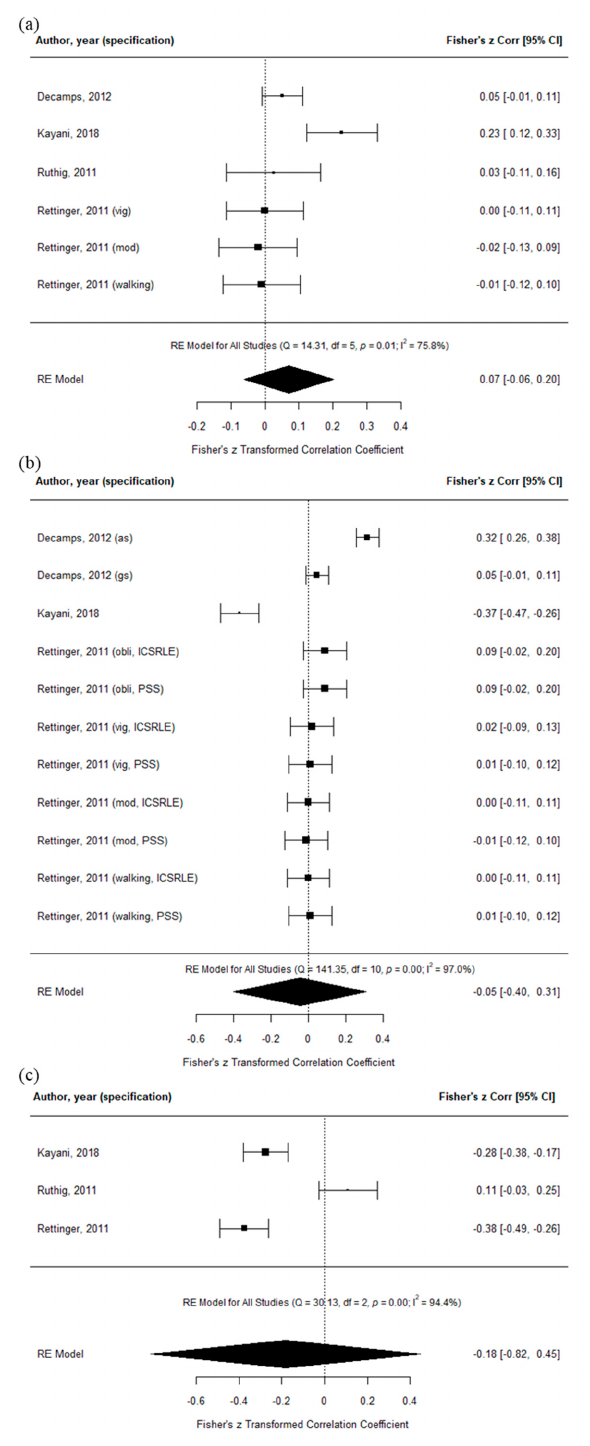
Figure 3. Forest plots of bidirectional relationships. ( a ) Physical activity and academic performance; ( b ) physical activity and stress; ( c ) stress and academic performance. Abbreviations: vig: vigorous physical activity; mod: moderate physical activity; as: academic stress; gs: general stress; obli: obligatory exercise; ICSRLE: Inventory of College Students’ Recent Life Experiences; PSS: perceived stress